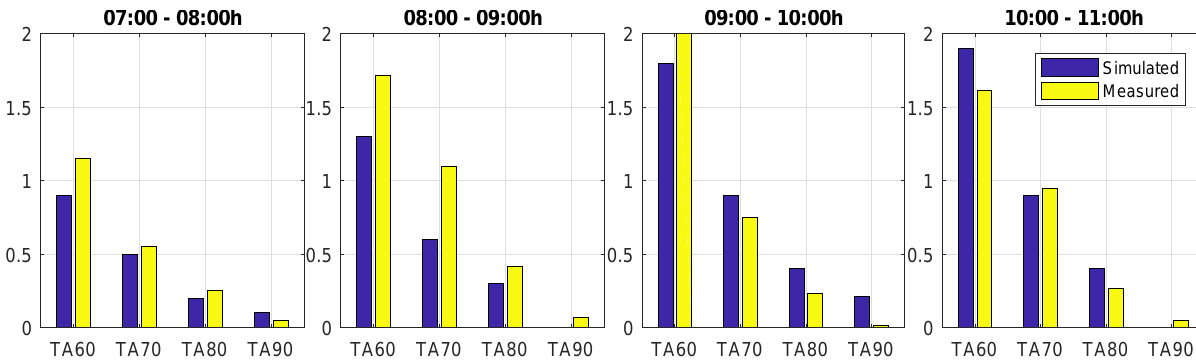
Figure 6: Comparison chart between measured and simulated TA, in minutes